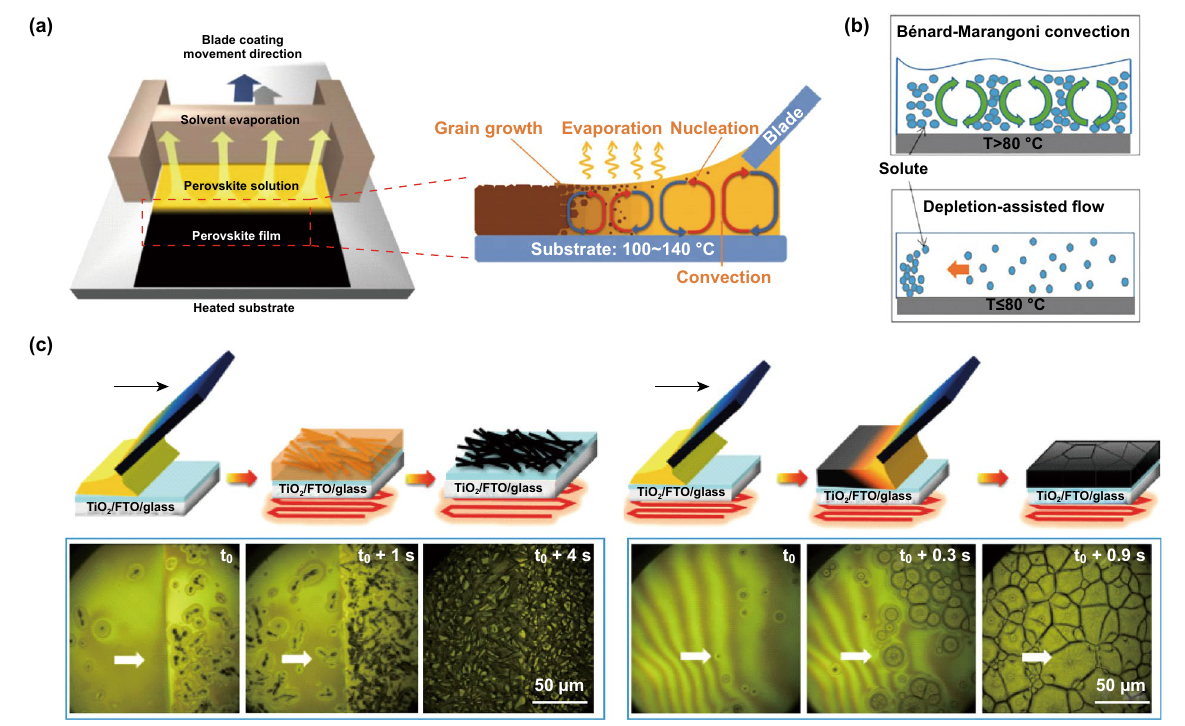
Fig. 8 a Scheme of the doctor-blade coating method [96]. Copyright © 2017 WILEY-VCH Verlag GmbH & Co. KGaA, Weinheim. b Sche- matic illustration of the Bénard–Marangoni convection and depletion-assisted flow of CsPbI 2 Br fluid at higher and lower processing tempera- tures, respectively [107]. Copyright © 2019 Elsevier Inc. c Schematic of the process and real-time optical microscopy: DMSO:GBL-blade-25 °C film and DMSO:GBL-blade-150 °C film during thermal annealing [97]. Copyright © 2018 Elsevier